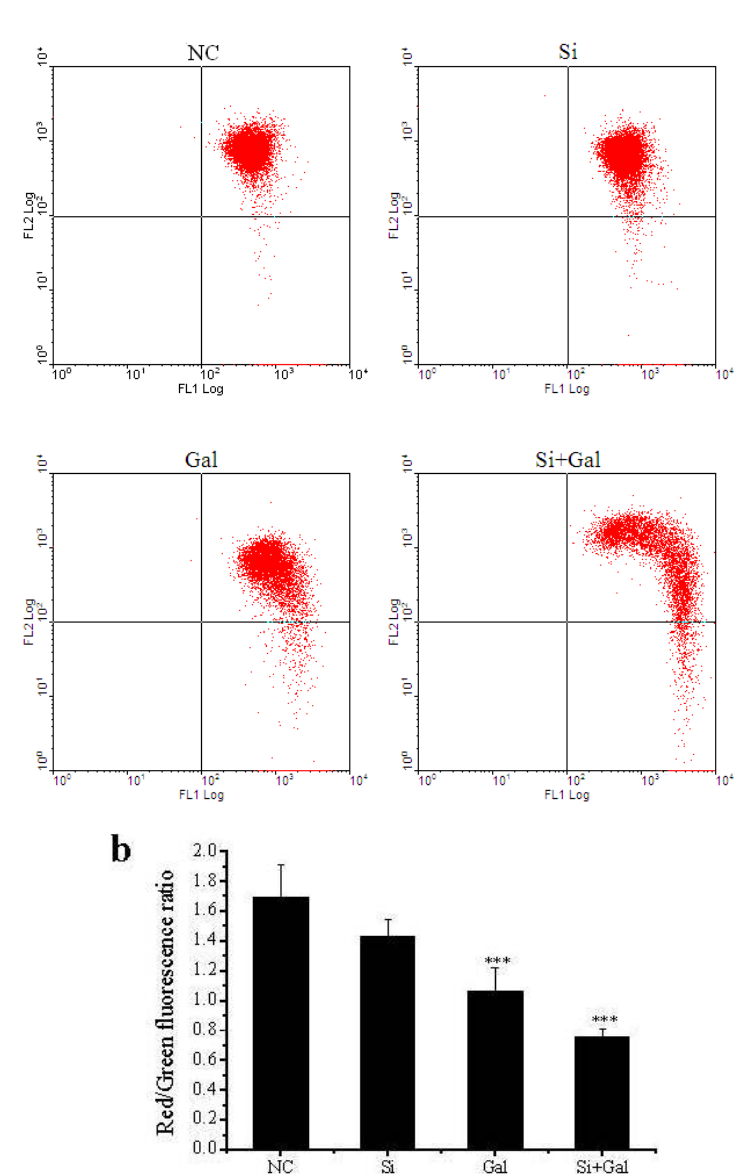
Figure 6. Quantitative analysis of Δψm using flow cytometry in hLE cells. ( a ) Changes of mitochondrial membrane potential (Δψm) in hLE cells; ( b ) Δψm was quantified using the ratio of red to green fluorescence. Data are the mean ± SD of at least three independent experiments. *** p < 0.001, compared to the negative control group. NC: negative control cells; Si: cells with SelR siRNA transfection for 24 h; Gal: cells exposed to D -galactose (150 mM) for 36 h; Si+Gal: cells with SelR siRNA transfection followed by D -galactose exposure.